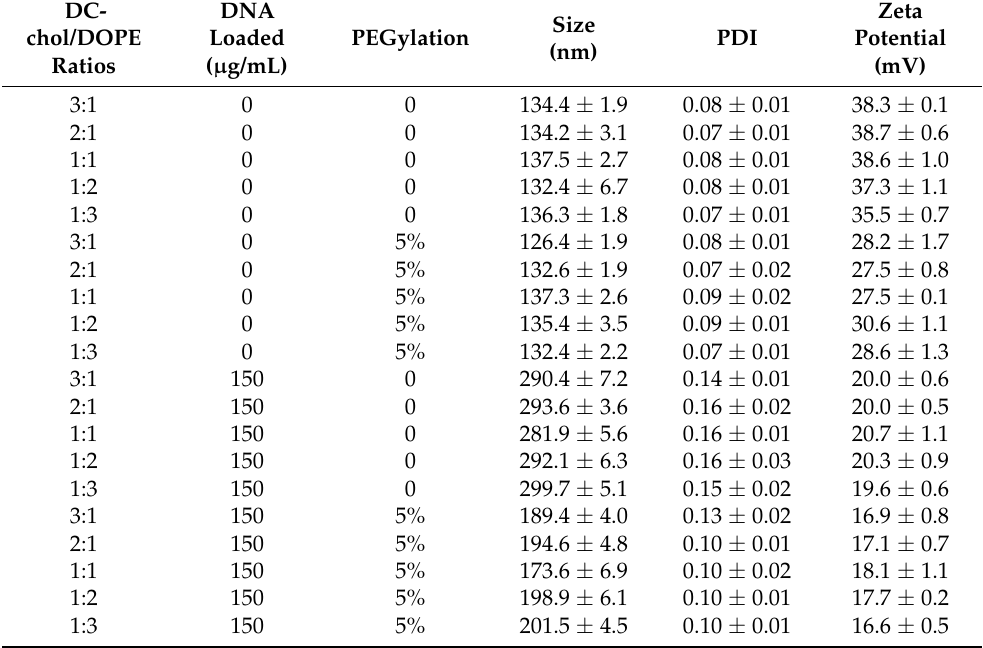
Particle size distribution, polydispersity index (PDI) and zeta potential of 3-[N- (N’,N’-dimethylaminoethane)-carbamoyl] cholesterol